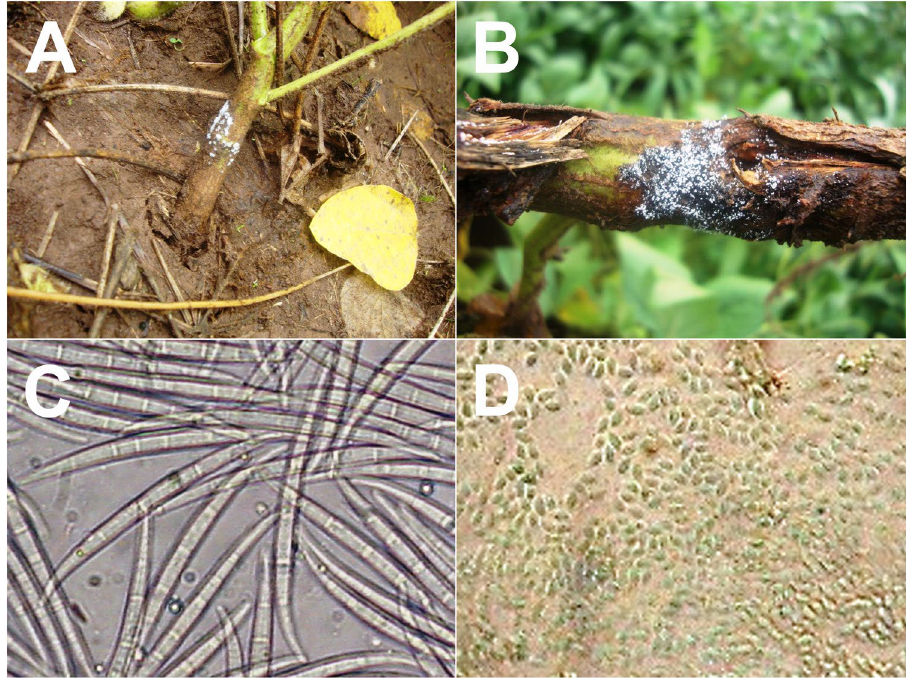
Figure 2. Fusarium species. ( A ) Fusarium incarnatum-equiseti . ( B ) Fusarium commune mass spores on soybean stem. ( C ) Fusarium incarnatum-equiseti macroconidia 3- to 5-septate curved spores (120 µ m). ( D ) Fusarium commune microconidia aseptate oval or elliptical spores (4.2 µ m). Figures ( A – D ) were obtained by Salgado-Neto.